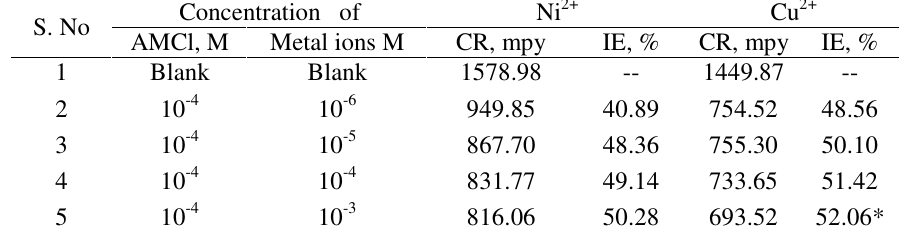
Table 3. Effect of metal ions (Ni 2+ & Cu 2+ ) on the IE of AMCl (10 -3 M) in the corrosion of MS in 1M H SO (5 h study) 2 4